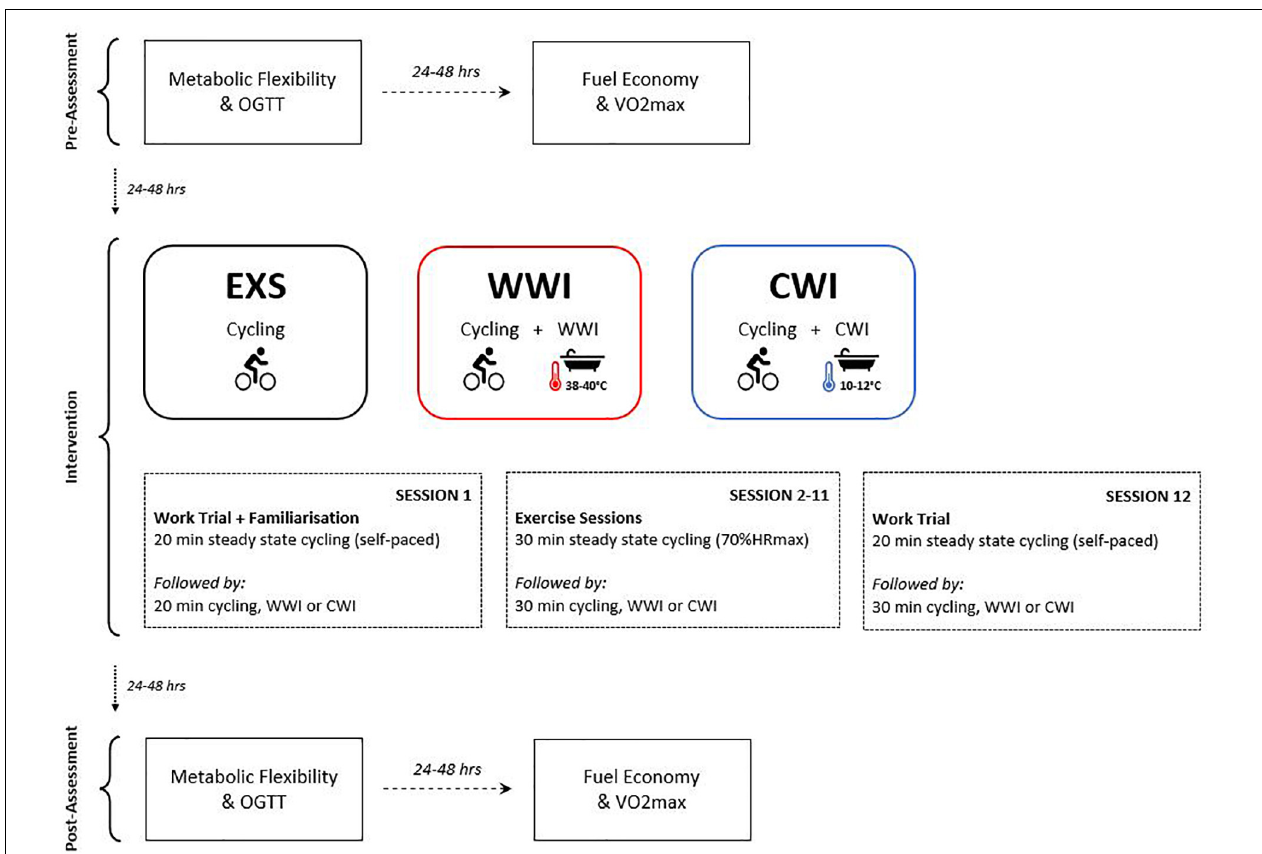
FIGURE 1 | Experimental design. Pre- and post-assessments (OGTT and VO2max) were performed with 24–48 h between each and prior to session one, and after session 12. Sessions 2–11 included the full protocols [EXS (60-min moderate intensity cycling), CWI (30-min cold WI + 30-min moderate intensity cycling) or WWI (30-min warm WI + 30-min moderate intensity cycling)]. A 20-min work trial was completed in session one and 12 followed by EXS, CWI or WWI (time-matched). Participants completed two out of three interventions with a 4-week washout separating each